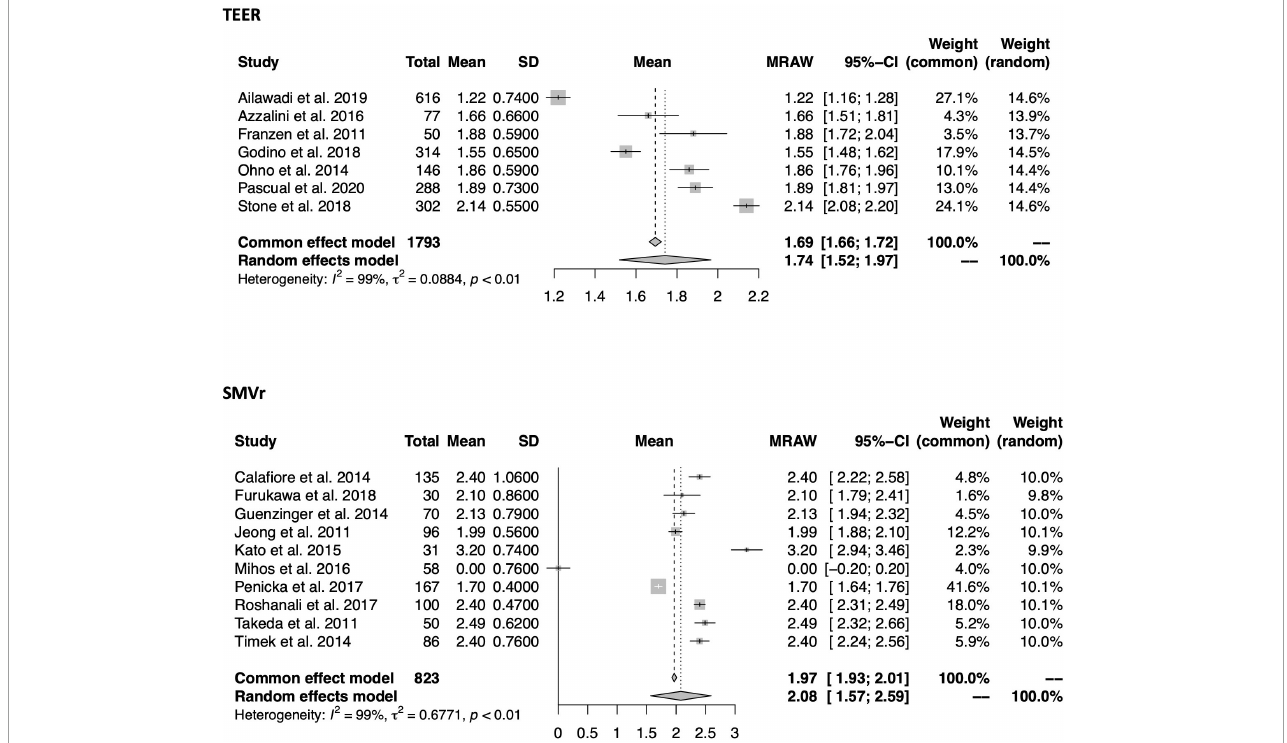
FIGURE8 Forrest plots of the comparison between TEER and SMVr for MR grade reduction. Mean MR reduction grade with pooled standard deviation were calculated for each study and included in the model. TEER, transcatheter edge-to-edge repair; SMVr, surgical mitral valve repair; MR: Mitral